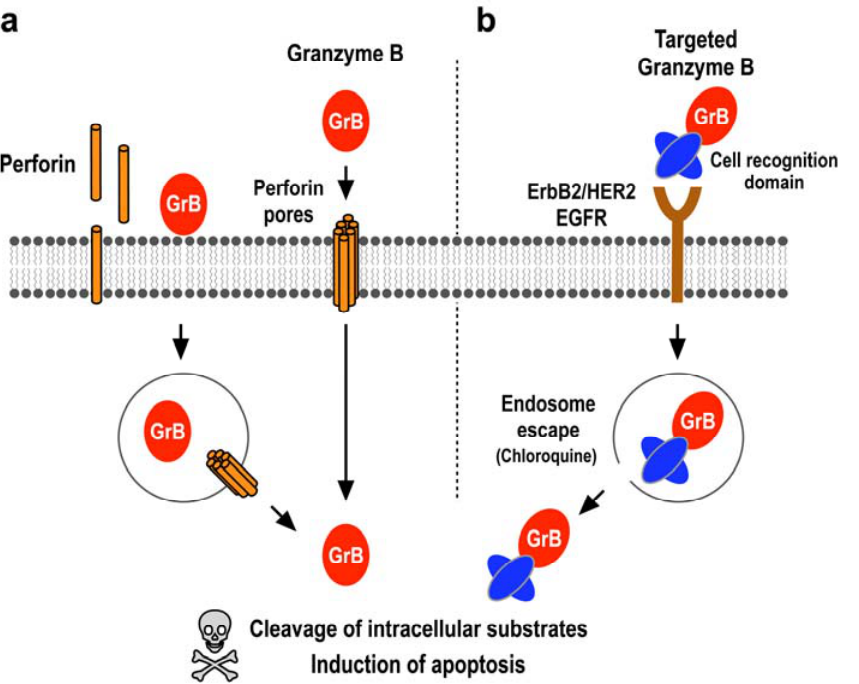
Figure 1. Cellular uptake of granzyme B and targeted granzyme B fusion proteins. ( a ) Perforin monomers released into the synaptic cleft bind to the target cell membrane, oligomerize, and undergo conformational rearrangement to form transmembrane pores. These may allow direct diffusion of GrB, or trigger co-internalization of perforin and GrB into vesicular compartments, followed by perforin-mediated endosomolysis and release of GrB into the cytosol [34,35]. ( b ) Targeted GrB derivatives specifically interact with tumor- associated cell surface antigens such as EGFR or ErbB2 via their heterologous cell binding domain. Receptor-mediated endocytosis then results in uptake into endosomes. Efficient endosome release and translocation to the cytosol can be achieved by addition of an endosomolytic activity such as chloroquine